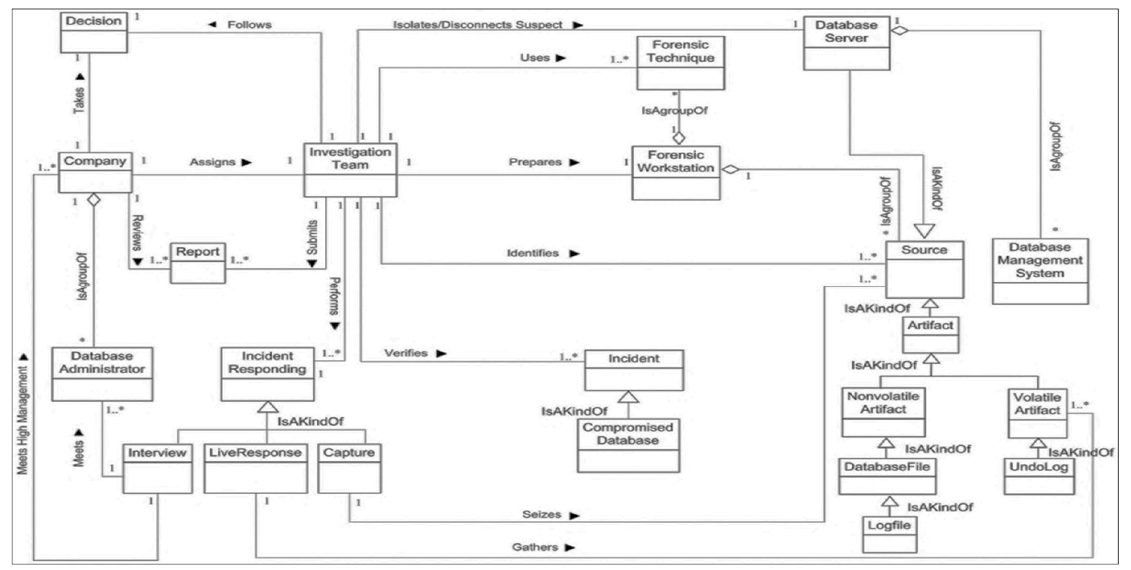
Figure 1. Database Forensic Investigation Metamodel (DBFIM) identification (Class 1).